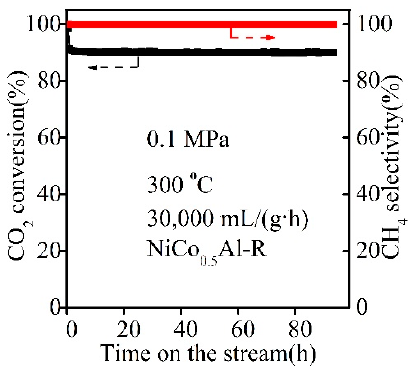
Figure 9. Stability test of the NiCo 0.5 Al-R catalyst.